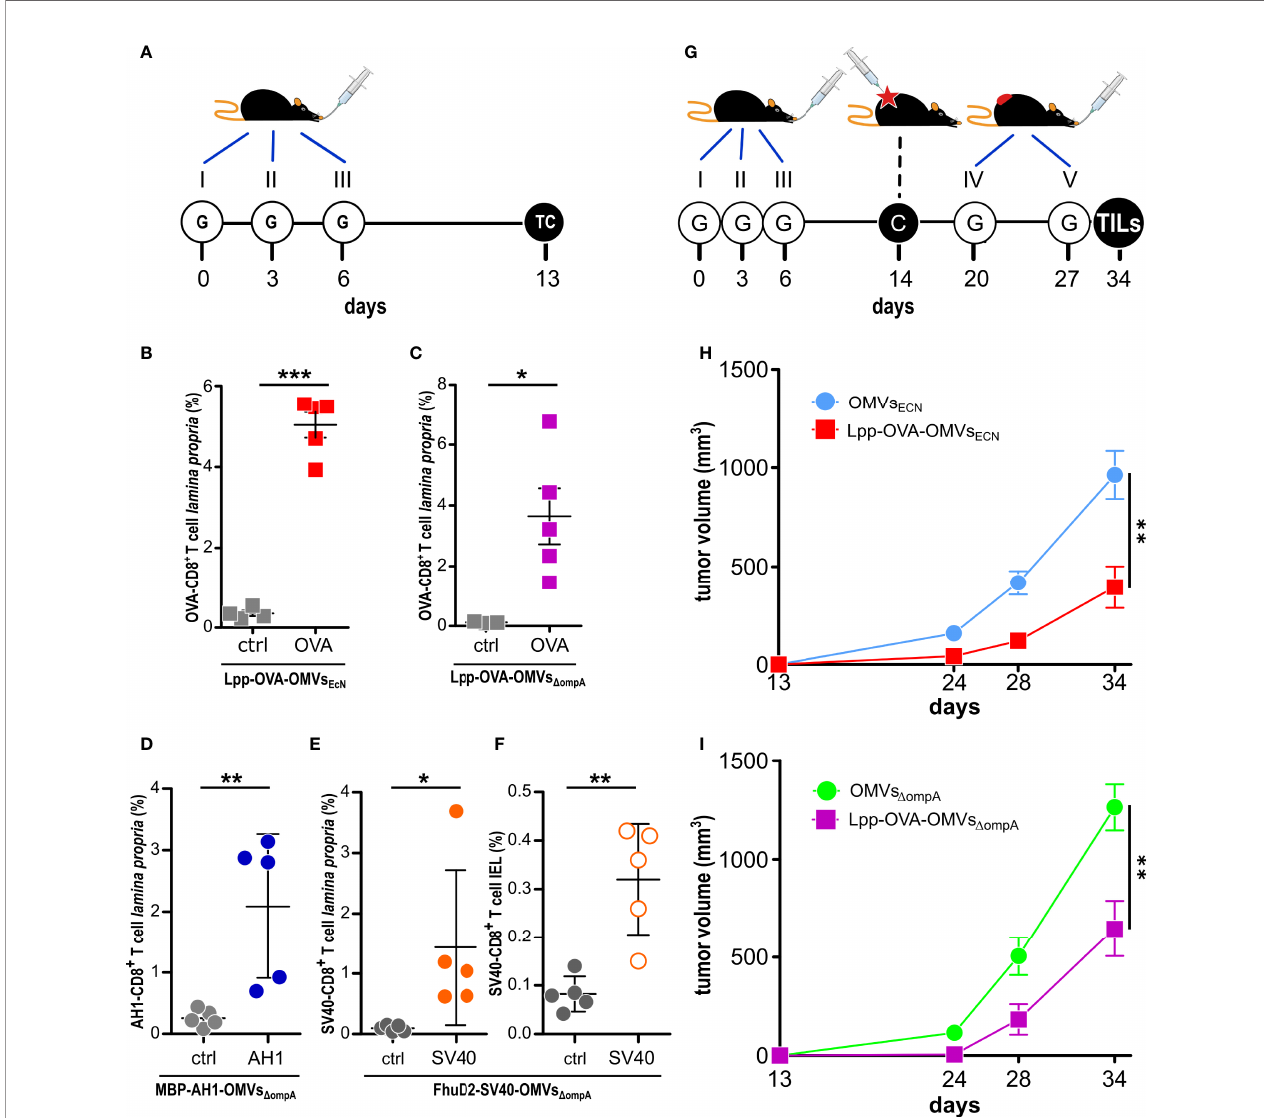
FIGURE 2 | Effect of oral administration of OMVs on anti-tumor responses. (A) Experimental protocol to analyze CD8 + T cell responses after administration of OMVs engineered with T cell epitopes . C57BL/6 mice were given three times 10 µg OMVs decorated with selected CD8 + T cell epitopes and one week after the last gavage epitope-speci fi c T cells (TC) from lamina propria and/or intestinal epithelium (IEL) were analyzed by fl ow cytometry. (B – F) Flow cytometry analysis of intestinal T cells . Animals were given OMVs engineered with speci fi c tumor epitopes as schematized in (A) and 1-2 x 10 6 cells were isolated from the lamina propria (B – E) and intestinal epithelium (F) of the small intestine and the frequency of OVA-speci fi c CD8 + T cells was measured by using epitope-speci fi c Dextramer-PE (OVA, AH1 or SV40). As negative control, an unrelated dextramer SSYSYSSL was used (ctrl). Data from one single experiment with 5 mice per group (for control analysis, at least three mice per group were analyzed). (G) Experimental protocol to study the tumor inhibitory activity of OMVs. Mice were given OMVs by oral gavage (G) and were subsequently challenged with OVA-B16F10 tumor cells. Tumor growth was monitored for 23 days and during this period two additional gavages were administered. (H, I) Analysis of OMV-mediated tumor inhibition. C57BL/6 mice were treated with OMVs from wild type and OVA-expressing EcN and E. coli BL21(DE3) D ompA as depicted in G and tumor volumes were measured over a period of 25 days. Combined data from three (15 mice in total per group) and two (15 mice in total per group) independent experiments for (H) and (I) , respectively). *P ≤ 0.05; **P ≤ 0.01; ***P ≤